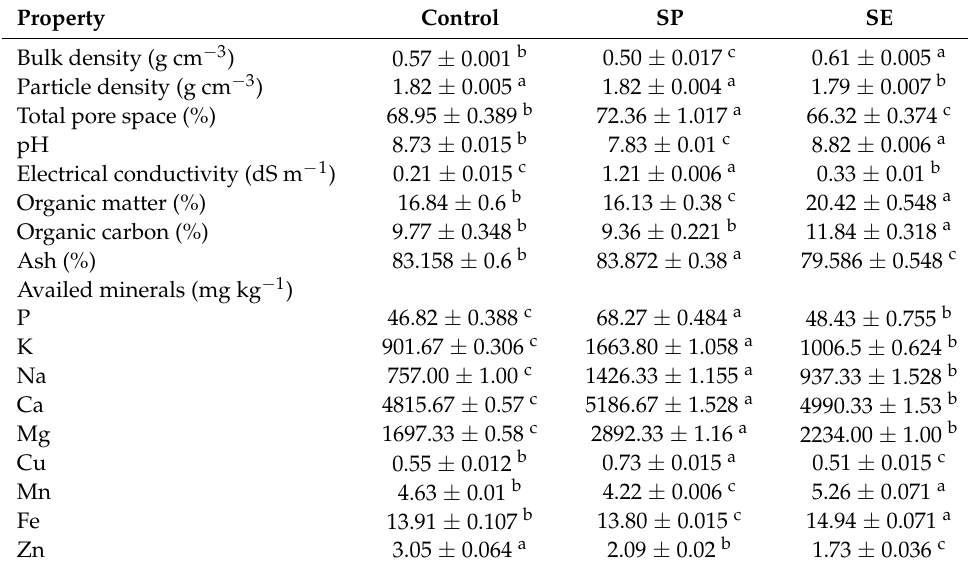
Table 4. Physicochemical characteristics of the substrate after a 45-day experiment.